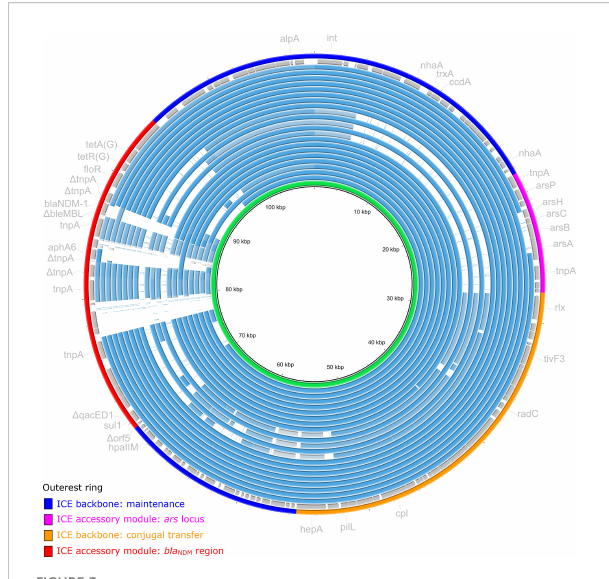
FIGURE 3 Alignment of ICE of A. caviae 211703 with related ICEs. ICE of A. caviae 211703 with 21 other similar ICEs deposited in the GenBank database were included. The rings of plasmids were arranged in the order (from inner to outer) as described in Table S5. The second outer ring colored in gray were annotations of ICE of A. caviae 211703. Highlighted on the outer ring represented functional regions (backbone regions and accessory